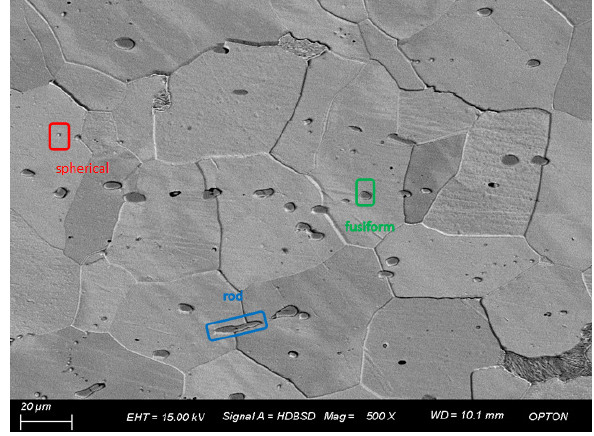
Figure 5. Morphology and quantity distribution of No. 2 steel inclusions.